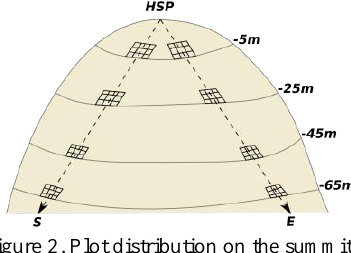
Figure 2. Plot distribution on the summits Vertical images of the plots are captured using a pole with a digital single-lens reflex (DSLR) camera attached held at approximately two metres height above the plots (Figure 3). Doing so, a flight path over the plot is simulated. Oblique images at three different incident angles from two different distances are captured by walking around the plot. Combining the vertical and oblique images a dome structure of camera positions around and above the plots is created minimizing possible occlusions and shadowing effects by rocks and rough terrain.